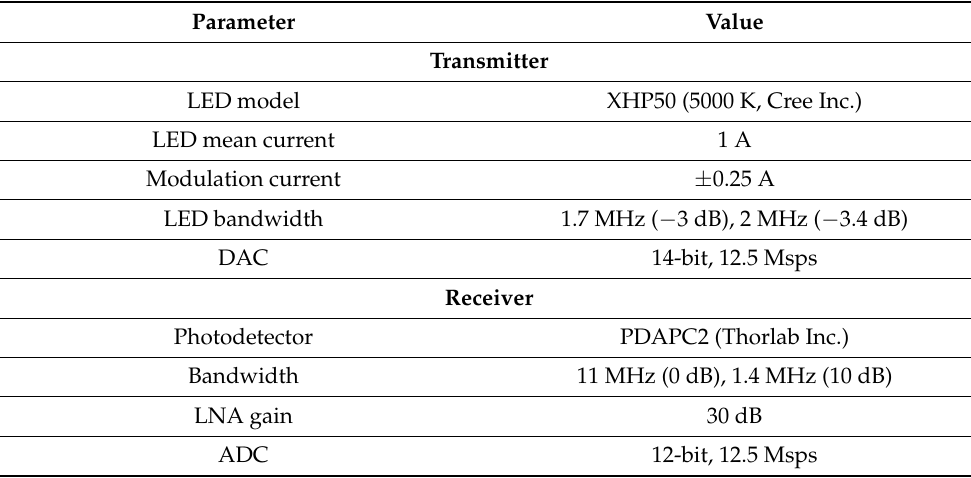
Table 3. Parameters of the experimental set ‐ up.